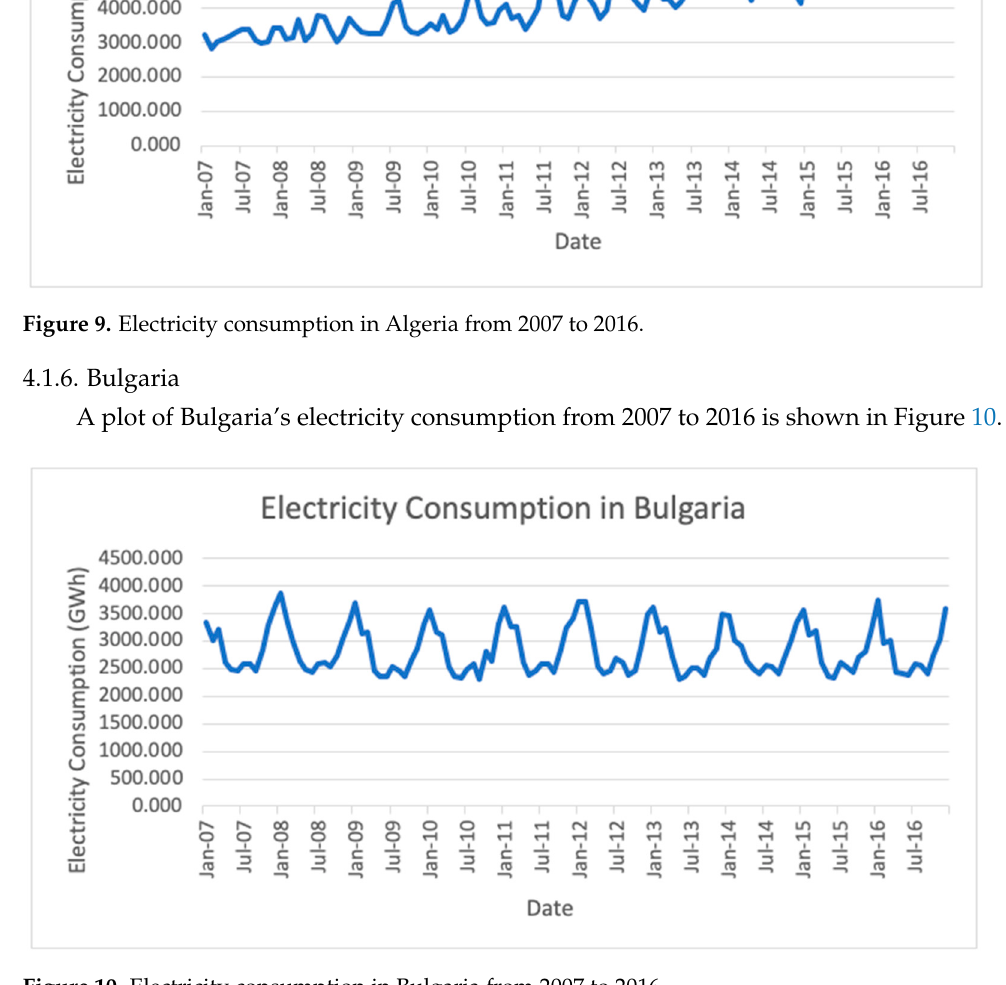
Figure 9. Electricity consumption in Algeria from 2007 to